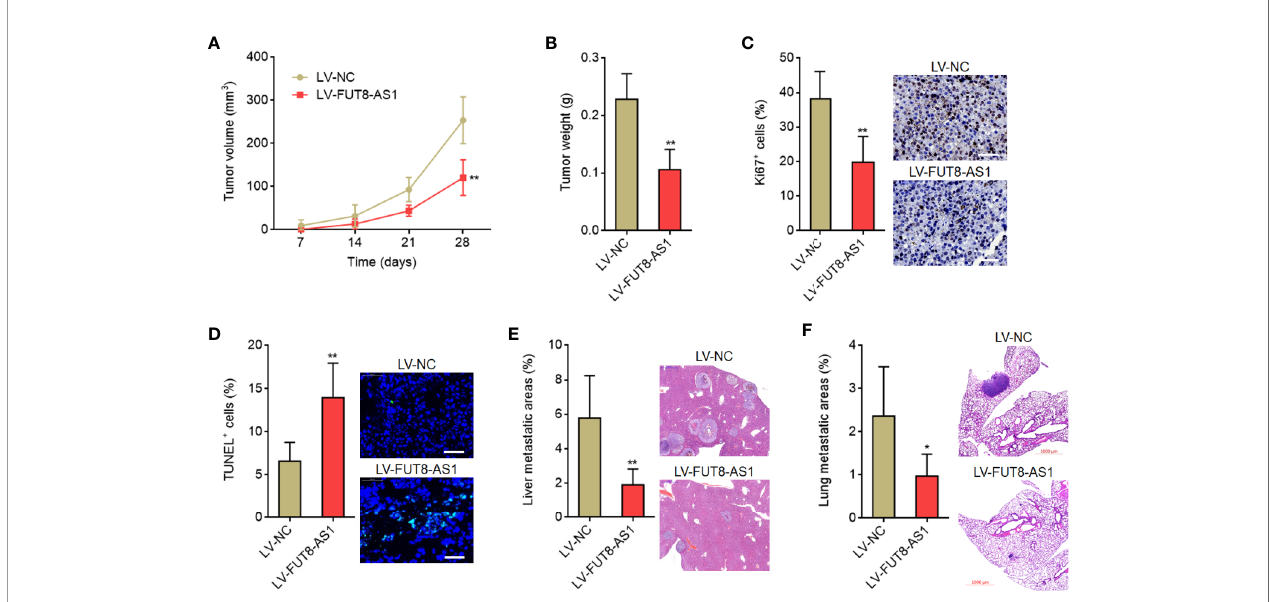
FIGURE 4 | FUT8-AS1 inhibits melanoma growth and metastasis in vivo . (A, B) CHL-1 cells overexpressing FUT8-AS1 or control were subcutaneously inoculated into nude mice. Tumor volumes were measured every 7 days (A) . The tumors were excised and weighed at the 28 th day after inoculation (B) . (C) The tumors formed by CHL-1 cells overexpressing FUT8-AS1 or control were used to perform Ki67 IHC staining. Scale bars, 50 µm. (D) The tumors formed by CHL-1 cells overexpressing FUT8-AS1 or control were used to perform TUNEL staining. Scale bars, 50 µm. (E) CHL-1 cells overexpressing FUT8-AS1 or control were inoculated into spleen of nude mice to construct liver metastasis model. The livers were excised and used to perform H&E staining. Scale bars, 500 µm. (F) CHL-1 cells overexpressing FUT8-AS1 or control were inoculated into tail vein of nude mice to construct lung metastasis model. The lungs were excised and used to perform H&E staining. Scale bars, 1,000 µm. Data are presented as mean ± SD. n = 6 mice in each group. * P < 0.05, ** P < 0.01 by Mann-Whitney